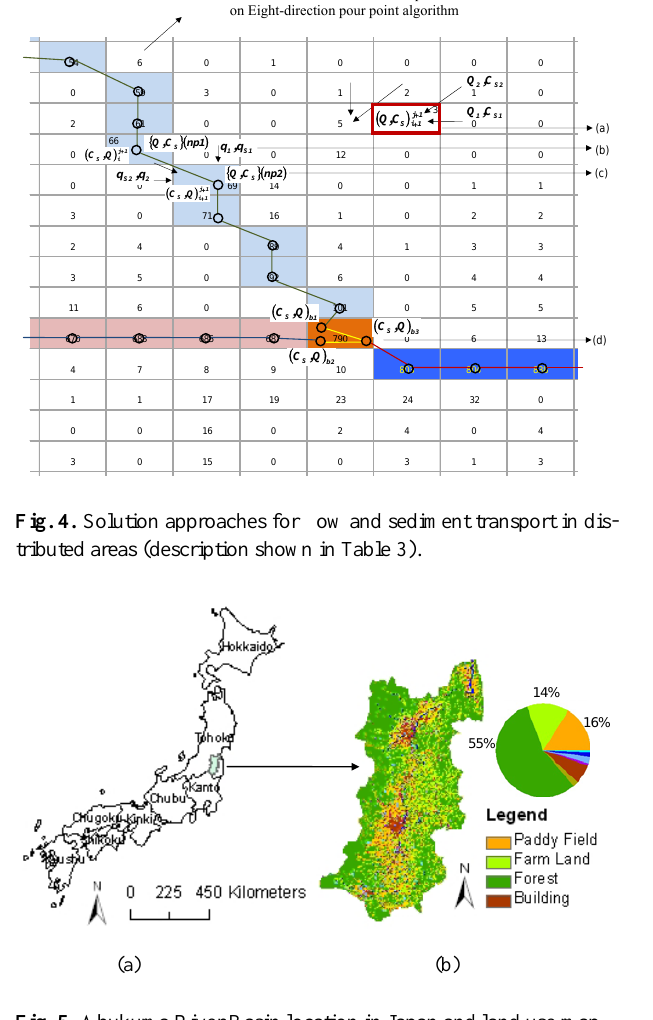
Fig. 6. Spatial data over view for Abukuma River Basin modelling.